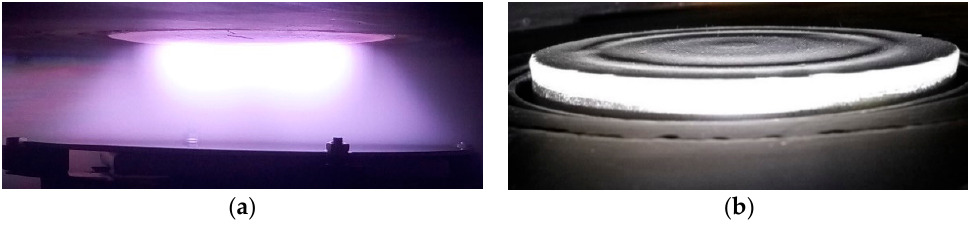
Figure 6. An RF magnetron discharge and a substrate holder ( a ), zone of HA target erosion after multiple deposition runs ( b ).